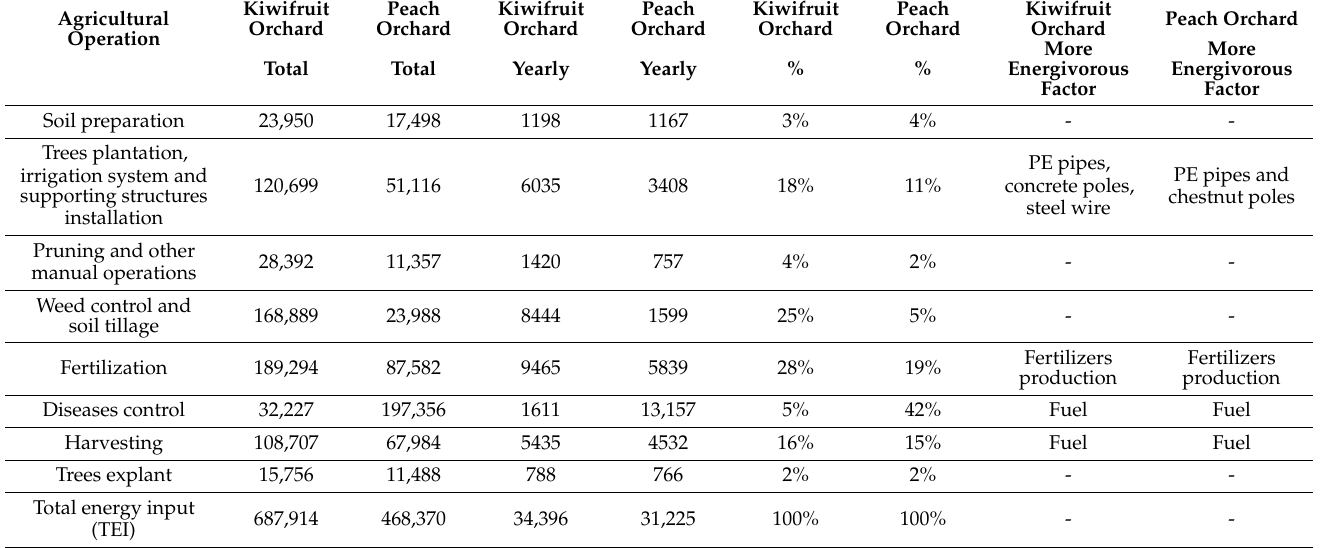
Table 5. Energy consumption per hectare (MJ ha − 1 ) from the examined fruit orchard systems (kiwifruit and peach orchards) in the whole production cycle (20 and 15 years for kiwifruit and peach orchards,